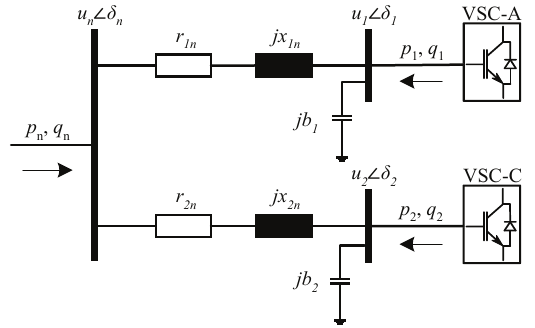
Figure 6. Offshore AC hub equivalent diagram for droop gain